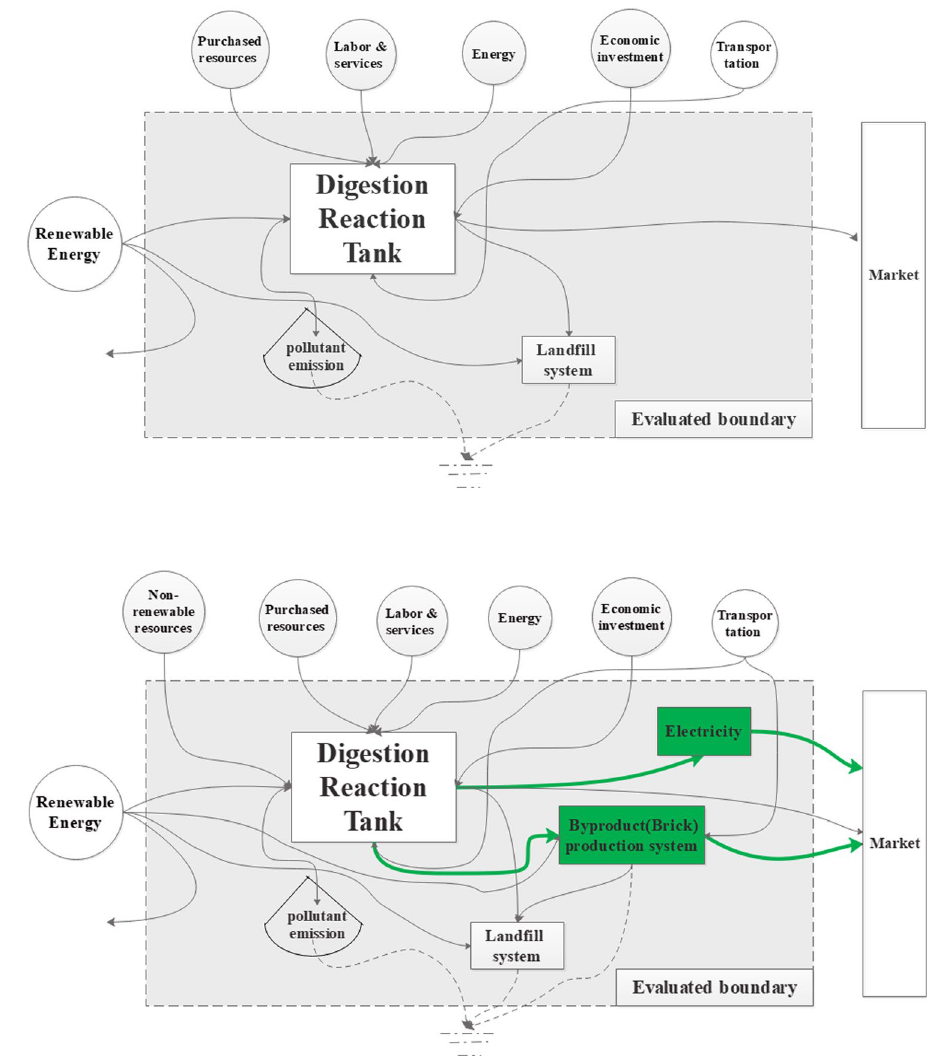
Fig. 3 Scenario A: the original emergy flow of sewage sludge treatment system